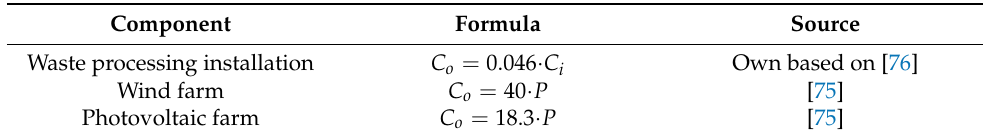
Table 5. Operating costs